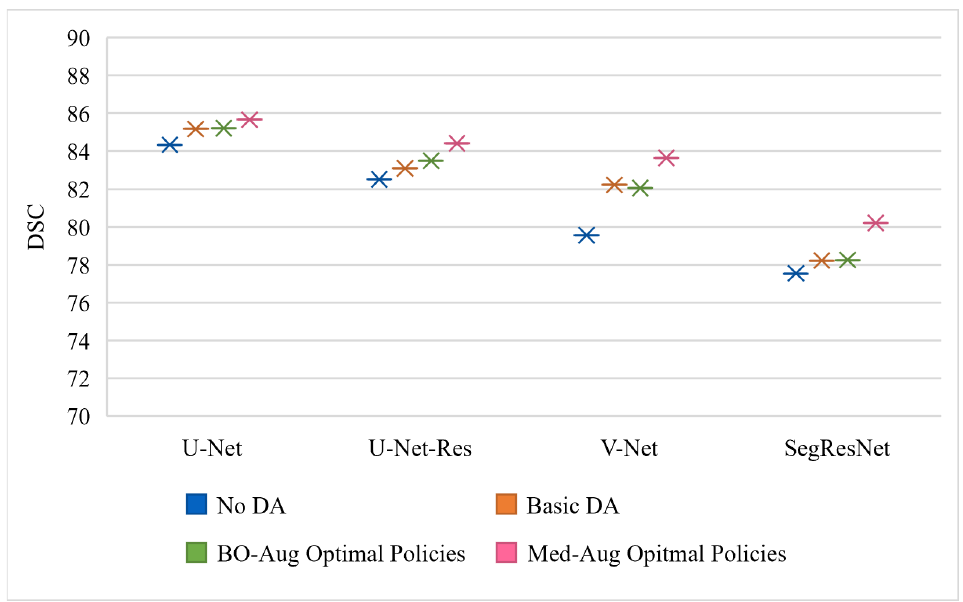
Figure 4. Visualization of the testing performance in DSC of four different neural networks using different DA policies on the training set for the Cardiac data experiments.